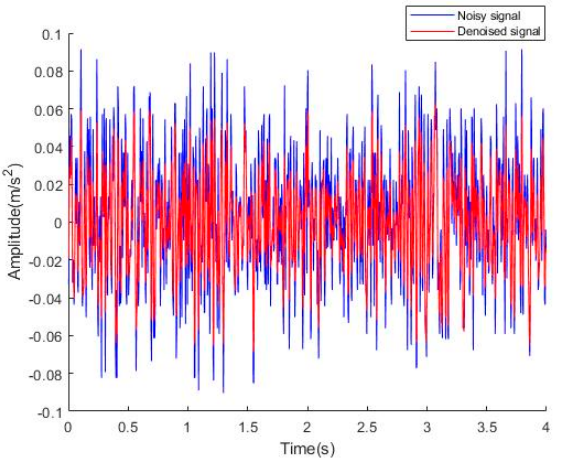
Figure 10. Time domain diagram of y -axis signal before and after denoising.